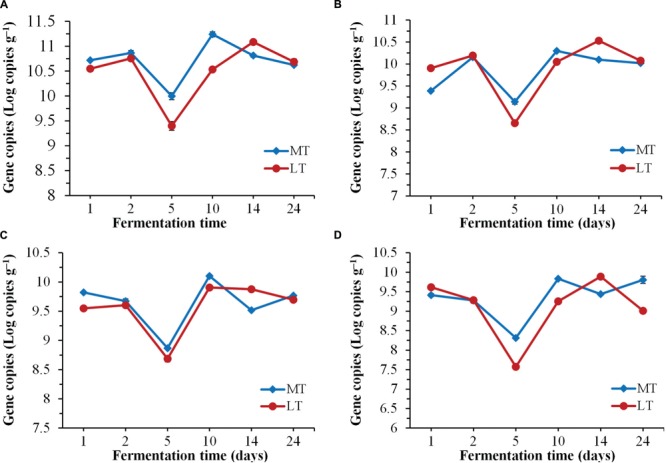
Dynamics of quantification of total bacteria (A), LAB (B), Bacillus(C), and fungi (D) during the MTSSF and LTSSF processes.